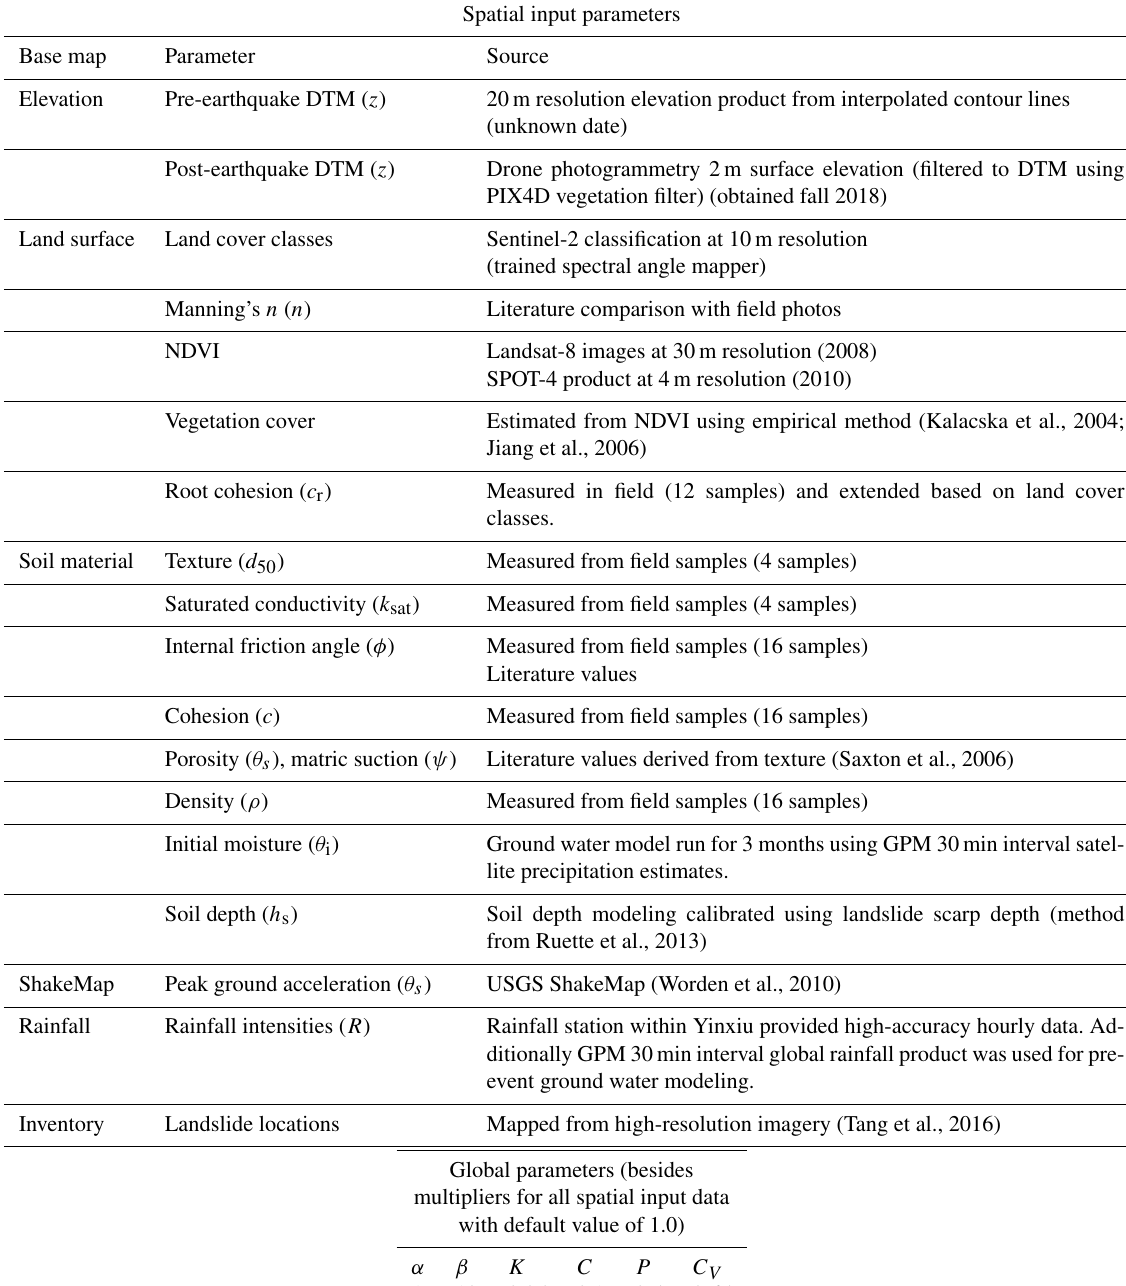
Table 1. List of input data and sources for the multi-stage multi-hazard modeling with OpenLISEM